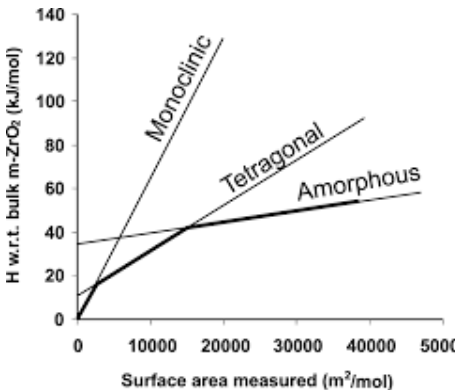
Figure 2. Volumetric energy in relation to surface area [44]. Copyright (2004) National Academy of Sciences, USA.